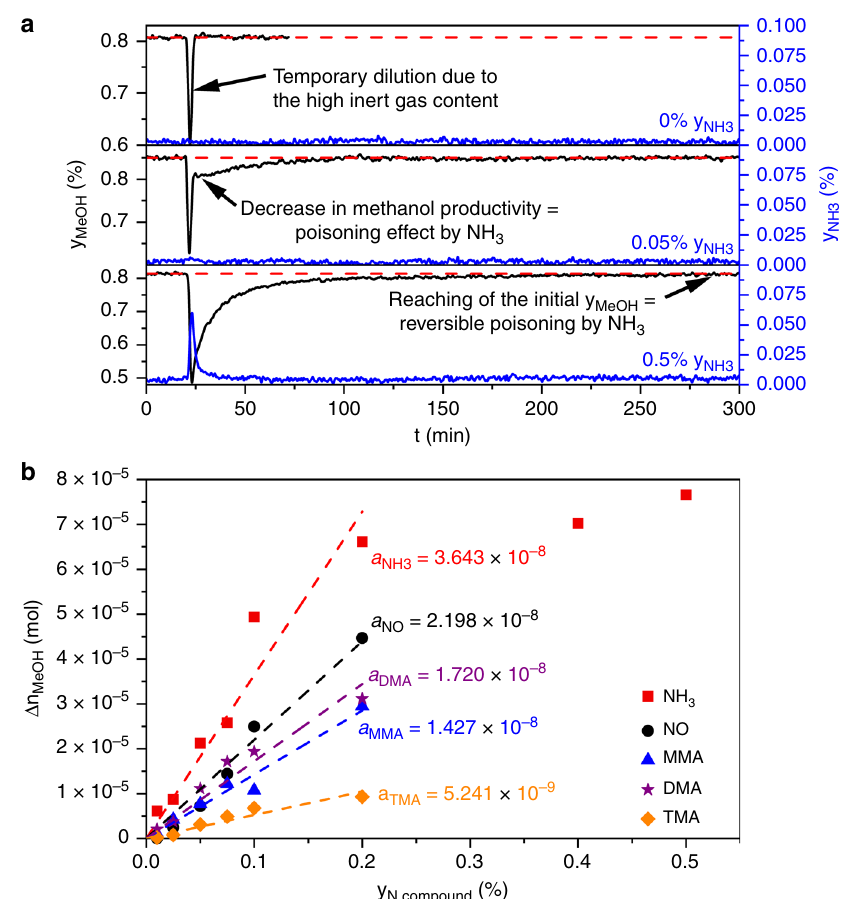
Fig. 1 High-pressure pulse experiments and the determined inhibition strengths. a Recorded methanol (black curves) and NH 3 (blue curves) mole fractions during the injection of pulses with different NH 3 partial pressures over the Cu/ZnO/Al 2 O 3 catalyst (conditions: 210 °C, 60 bar, 13.5% CO, 3.5% CO 2 , 73.5% H 2 , 9.5% N 2 ). b Correlation of the determined Δ n MeOH (non-produced amount of methanol over a de fi ned period of time) values (Supplementary Note 1) with the injected mole fractions of the investigated N compounds (NH 3 red squares and line, NO black points and line, monomethylamine (MMA) blue triangles and line, dimethylamine (DMA) violet stars and line, trimethylamine (TMA) orange diamonds and line). The corresponding pulse experiments are shown in Supplementary Figs. 1 – 5. a , the slope of the corresponding linear interpolation, is de fi ned as the inhibition